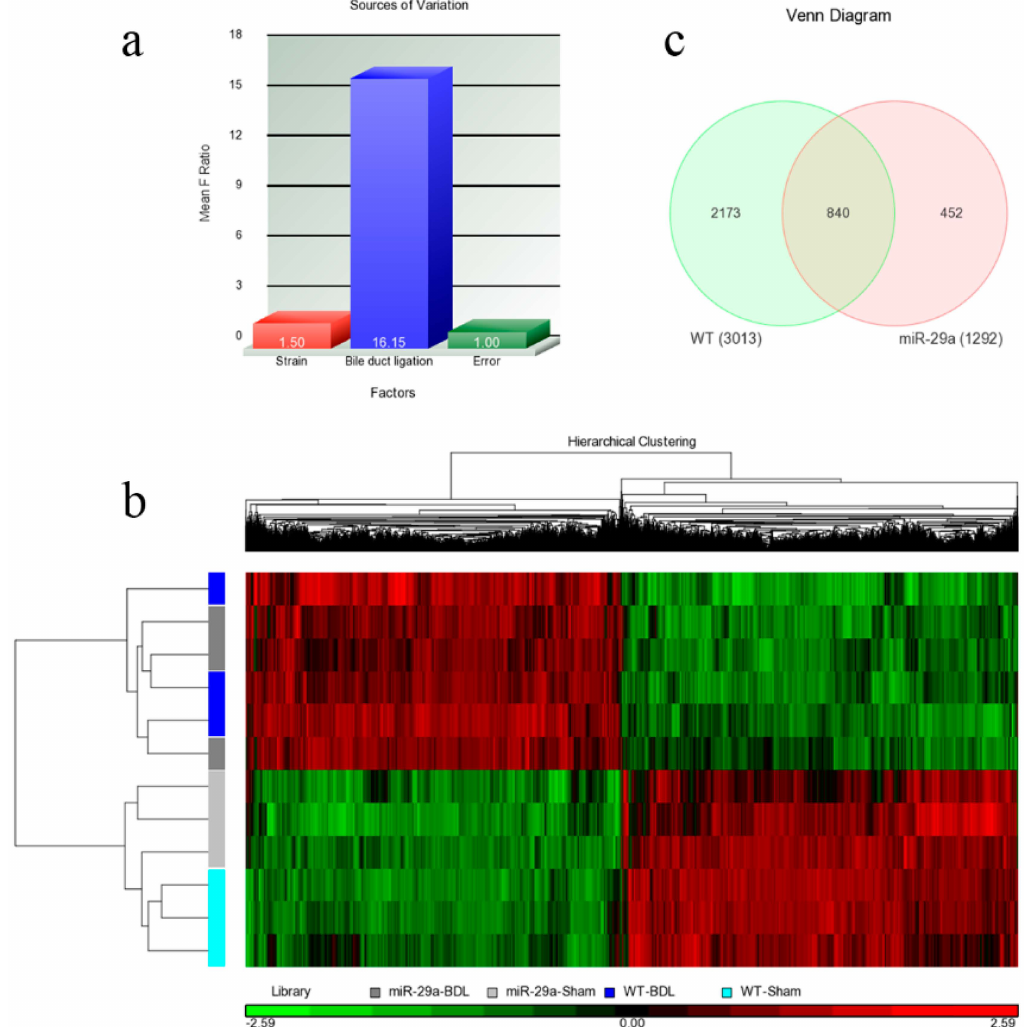
Figure 2. Overall gene expression changes. We used Agilent SurePrint G3 Mouse GE 8 ˆ 60 K microarray chips to study the gene expressions. ( a ) The source of the variation plot shows that the bile duct ligation factor accounted for most of the variation; ( b ) The heat map illustrated the clustering of the sample sets; ( c ) WT denoted the WT-BDL vs. WT-sham comparison, while miR-29a denoted the miR-29a-BDL vs. miR-29a-sham comparison. The digits in the Venn diagram denote the number of DE genes in the set differences and their